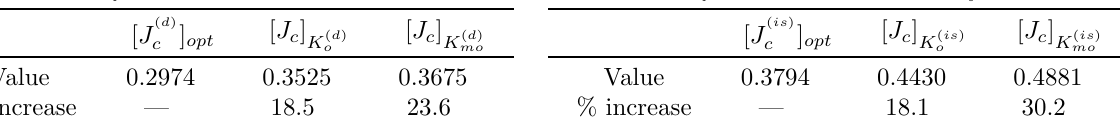
Table 1: Quadratic cost: direct actuation Table 2: Quadratic cost: inter-story